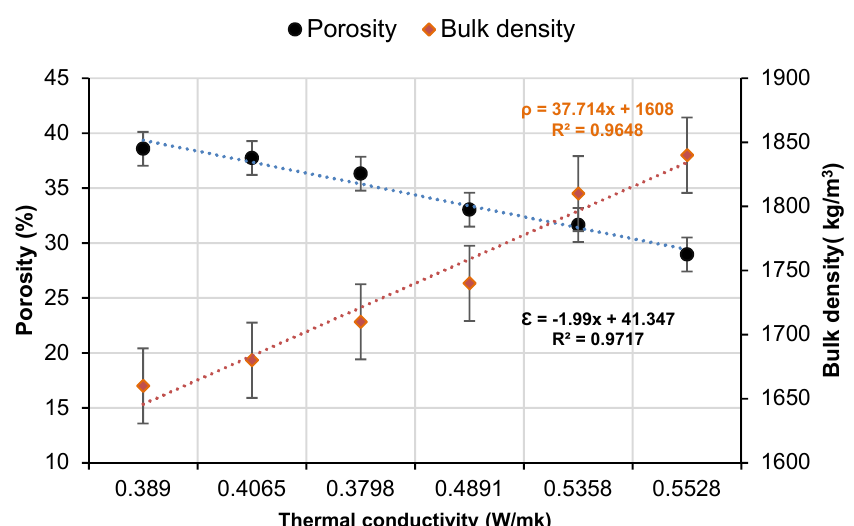
Figure 7. Thermal conductivity and specific heat of different CEBs. Figure 10. Thermal conductivity and specific heat of different CEBs.